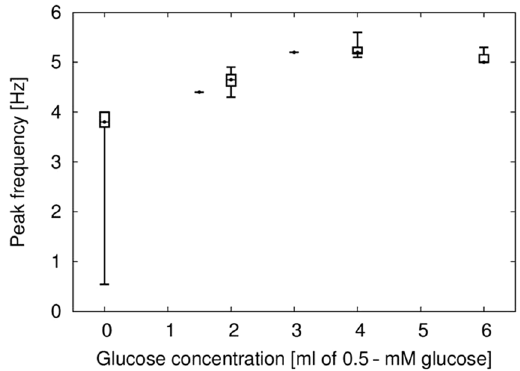
Figure 5. Dose-dependent response of the pulse generator as a function of glucose concentration: the strategy enabled a biosensor with the pulse generator circuit with selectivity for the detection of glucose. The frequency is gradually increases according to each drop by adding sufficient amount of glucose to the bioinspired